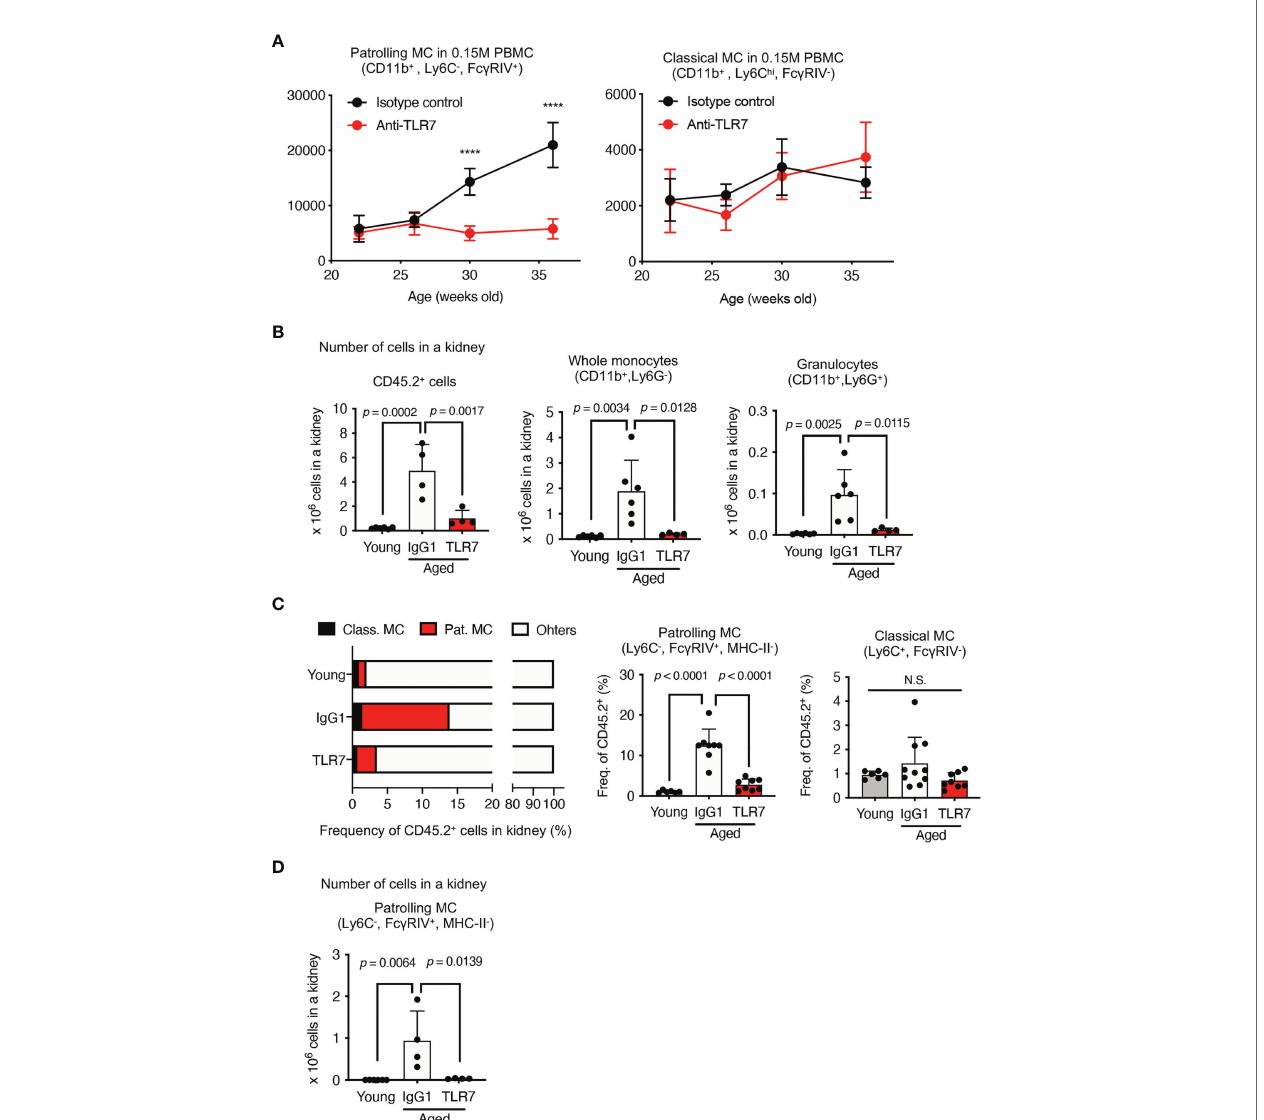
FIGURE 5 | Anti-TLR7 mAb inhibited patrolling monocyte increases in circulation and kidneys. (A – D) NZBWF1 mice were administered saline, IgG1 or anti-TLR7 mAb from age 12-16, to 35-40 weeks. (B – D) Young (pre-onset) NZBWF1 mice without treatment aged 12 weeks. (A) Average numbers of patrolling and classical monocytes in 15 x 10 4 PBMCs of NZBWF1 mice administered control IgG1 ( n = 4) or anti-TLR7 mAb ( n = 7). (B) Numbers of CD45.2 + leukocytes, CD11b + Ly6G - , and CD11b + Ly6G + monocytes in kidneys. Young mice ( n = 6), NZBWF1 mice treated with control IgG1 ( n ≥ 4), or anti-TLR7 mAb ( n ≥ 4). (C) Ratios (%) of classical monocytes, patrolling monocytes, and other leukocytes in the kidney. (D) Numbers of patrolling monocytes in kidneys. Data were statistically analyzed by 2-way ANOVA (A) or ordinary one-way ANOVA (B – D) . For 2-way ANOVA, Sidak ’ s multiple comparisons test was performed to calculate the row factor at each age. **** p < 0.0001; N.S., not signi fi cant. For ordinary one-way ANOVA, the results found signi fi cant by ANOVA ( p < 0.05) were further assessed by Tukey ’ s multiple comparison tests. Data are shown as individual points and as means ± SD for each experimental